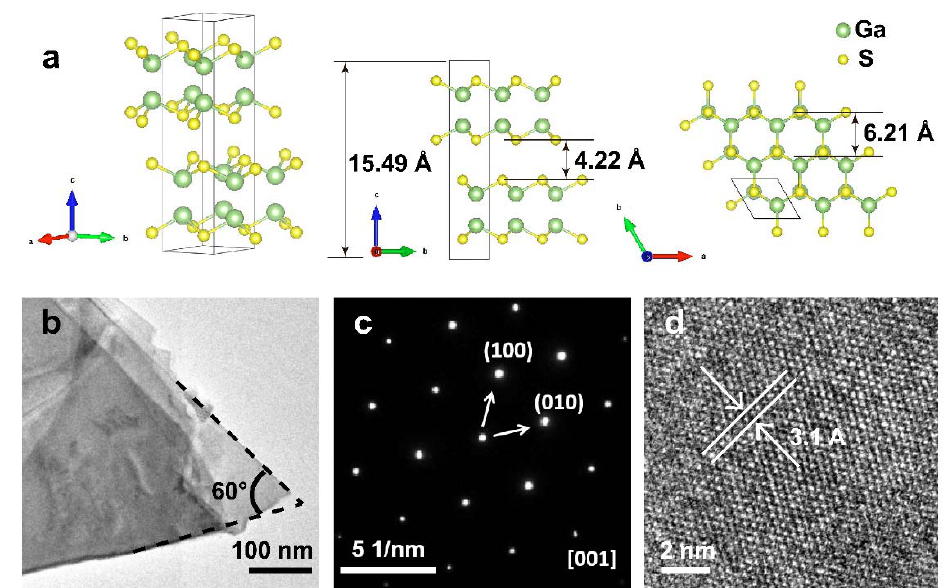
Figure 1. High ‐ quality hexagonal structured GaS crystals synthesis and characteristics. ( a ) Sche ‐ matic diagram of GaS crystal growth via a chemical ‐ vapor transport (CVT) method. ( b ) Image of Figure 2. Crystals structural of the layered GaS crystals. ( a ) schematic of the atomic structure of GaS GaS flake next to the steel ruler. ( c ) Mechanically stripped GaS crystals under microscope. ( d ) AFM (left: middle: side ‐ view, right: top ‐ view). The big green ball represents Ga atom, and the small yel ‐ height profile of the GaS nanosheet on a SiO 2 /Si substrate. ( e ) Secondary electron image. ( f ) The EDX low ball stands for S atom. ( b ) Low ‐ magnification TEM image. ( c ) SAED pattern. ( d ) High ‐ resolution spectra. ( g ) X ‐ ray diffraction pattern of GaS crystals. ( h ) Raman spectra of few ‐ layer GaS nanosheets. TEM image.